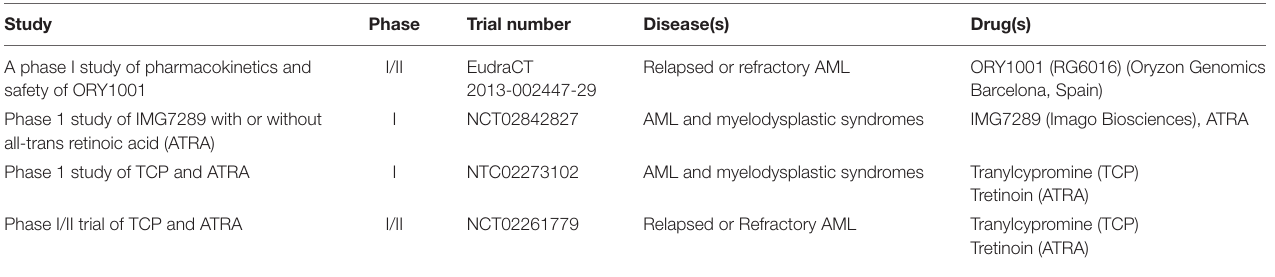
TABLe 1 | LSD1 inhibitors currently tested in clinical trials for acute myeloid leukemia